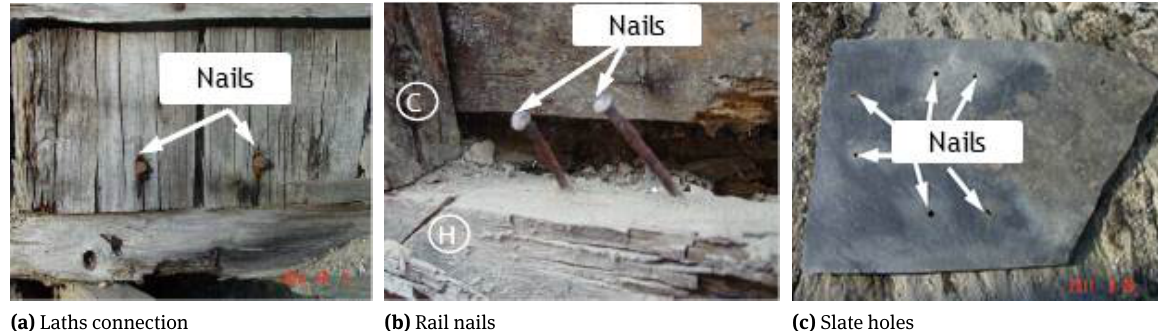
Figure 3: Connection between